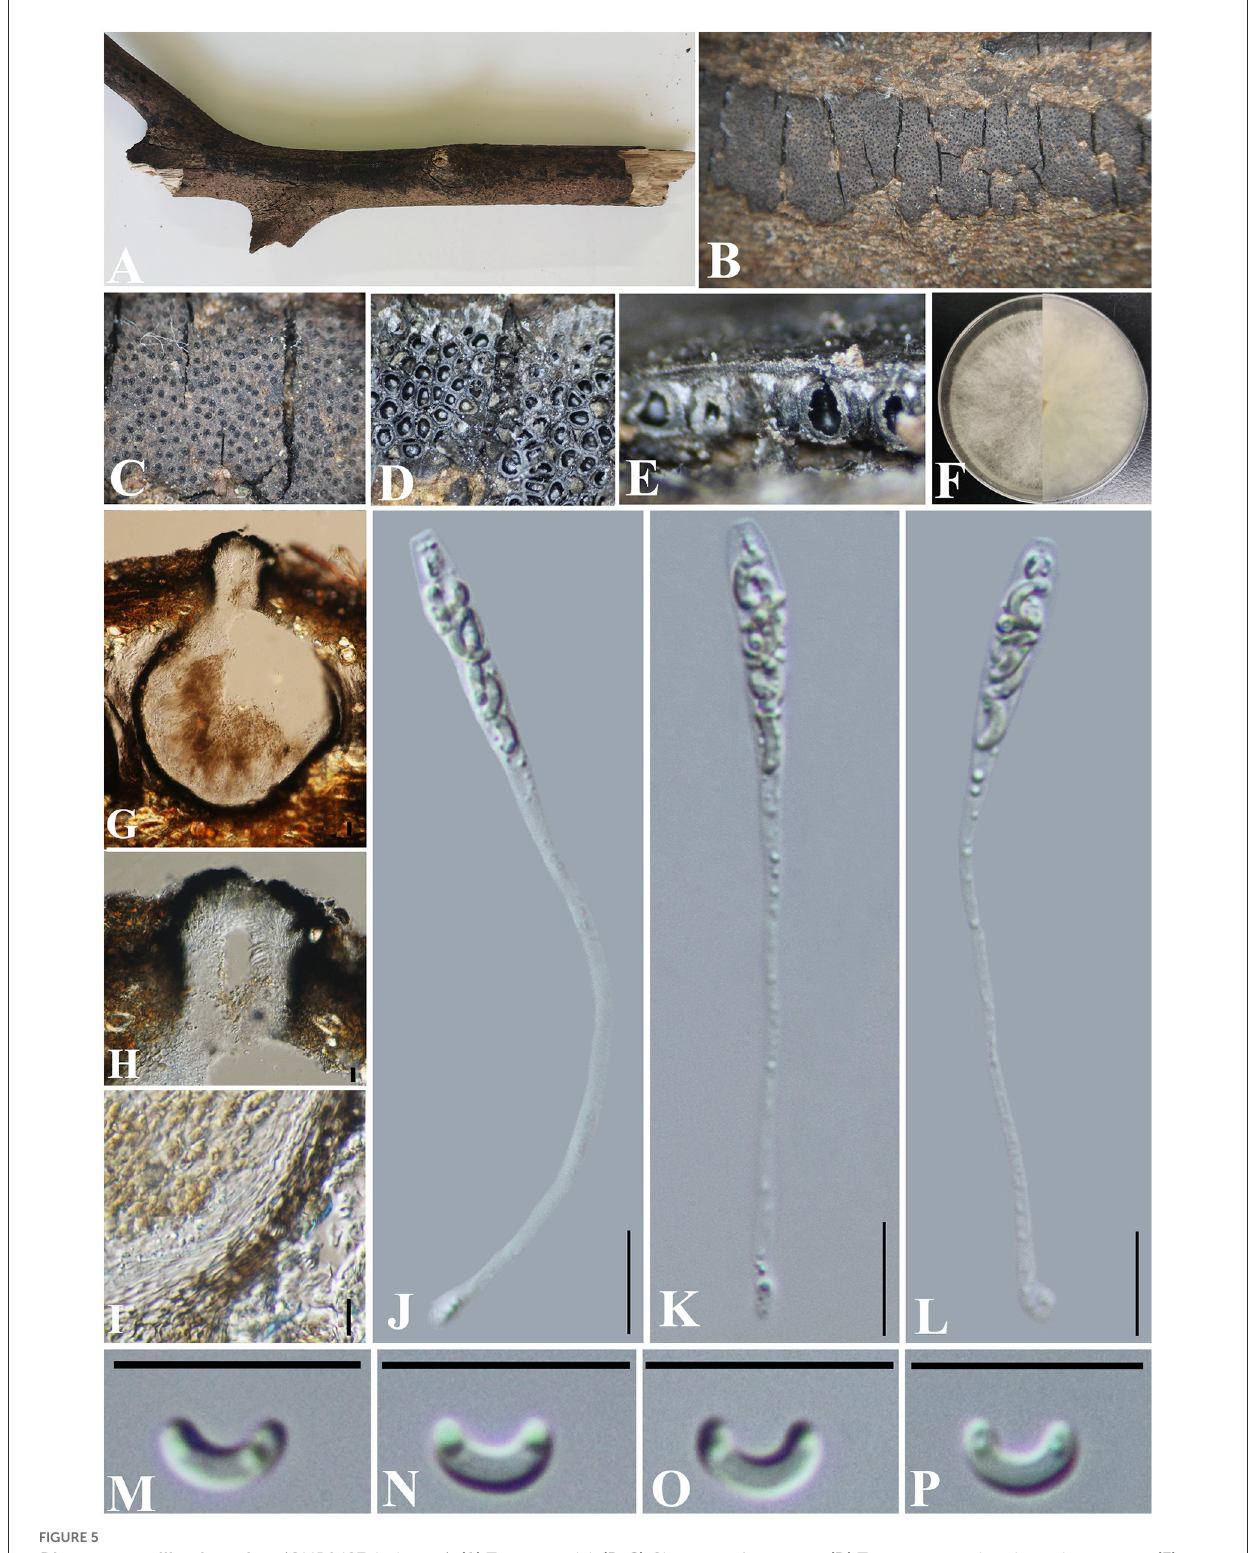
FIGURE5 Diatrype camelliae-japonicae (GMB0427, holotype). (A) Type material. (B, C) Close-up of stromata. (D) Transverse section through stromata. (E) Vertical section through stromata. (F) Culture on PDA. (G) Section through the ascostroma. (H) Ostiolar canal. (I) Peridium. (J–L) Asci. (M–P) Ascospores. Scale bars: (G) = 50 µ m; (H–P) = 10 µ